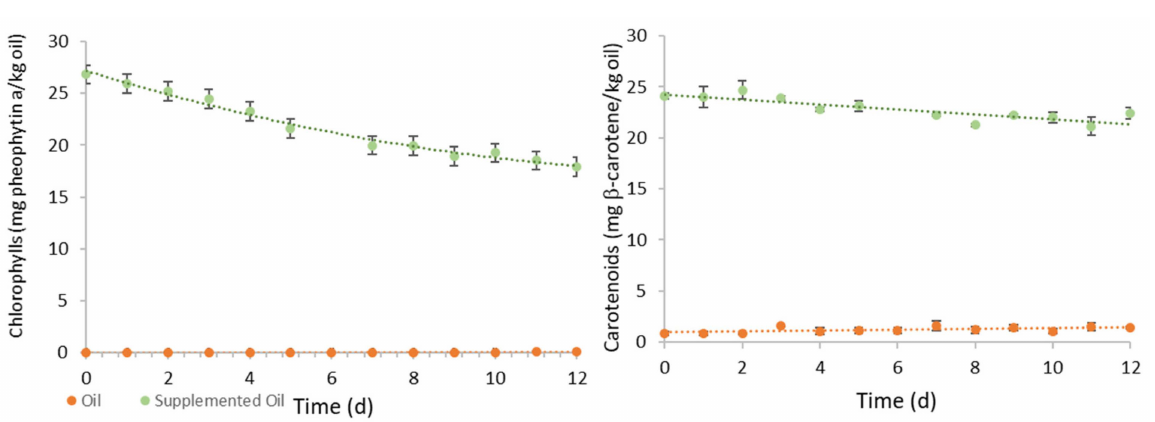
Figure 6. Evolution of the contents of chlorophyll pigments (mg pheophytin a/kg oil) and carotenoids (mg β -carotene/kg oil) in non-supplemented and supplemented oil samples, along storage at 60 ◦ C for 12 days under